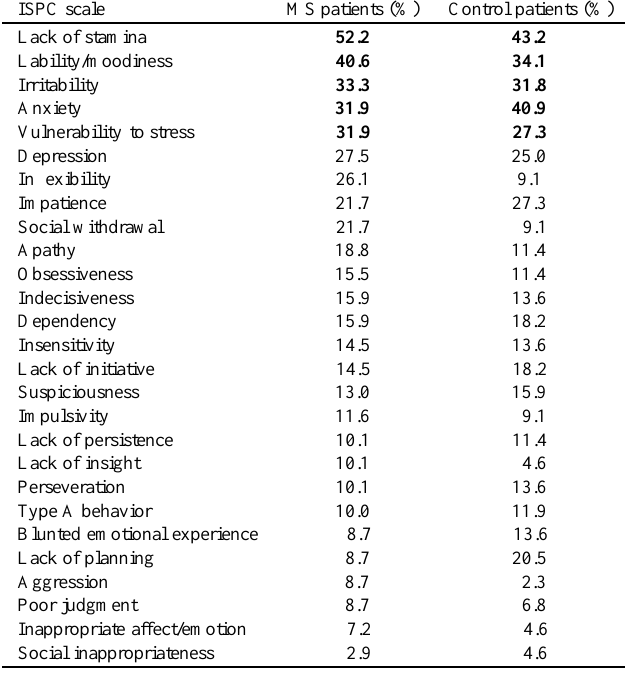
Table 3 Percentage of MS and control patients showing a PBC for each of the 26